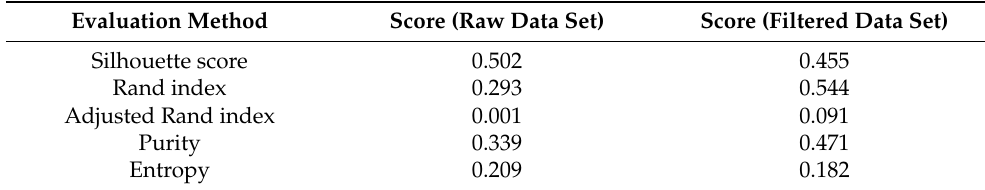
Table 2. The evaluation results for the daily consumption patterns.